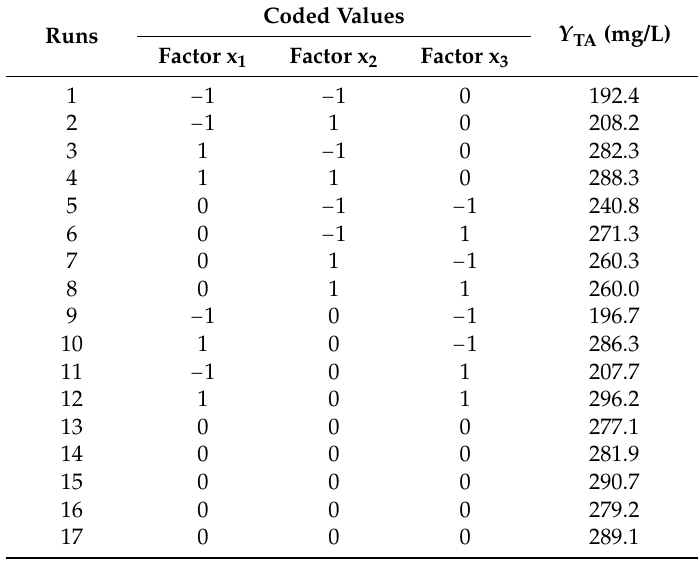
Table 2. Experimental ranges and levels of the independent variables for mycelial TA